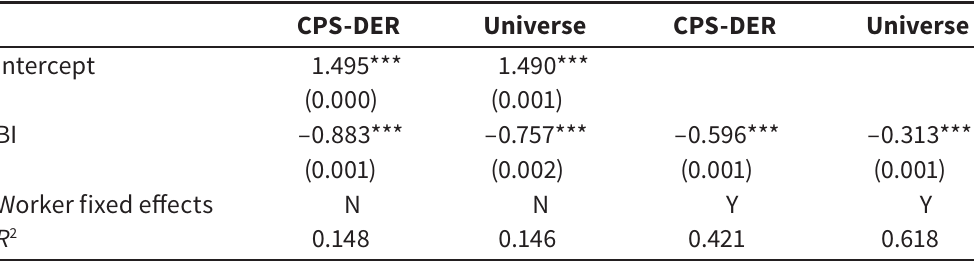
Regression of number of wage and salary jobs worked on BI Intercept from any wage and salary employer in the year.